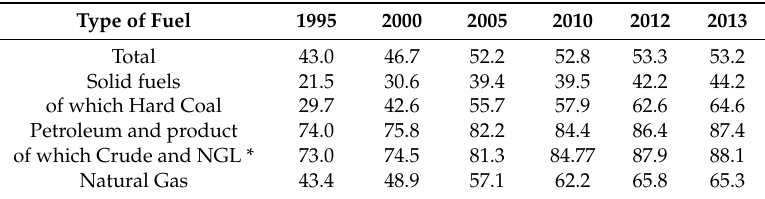
Table 1. EU-28 Energy Import Dependency by Fuel (%) adapted from [10]. With permission from © European Union, 2015.